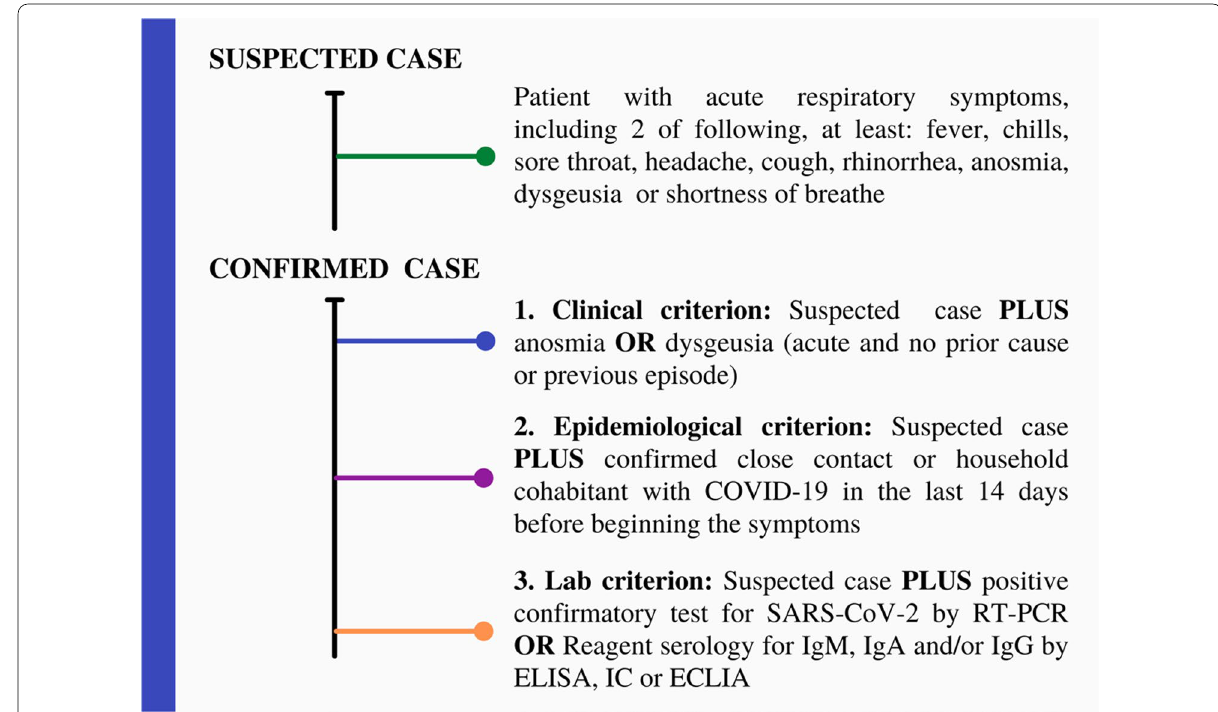
Fig. 1 Outcome definition: participants were classified according to the Brazilian Ministry of Health (BMH) criteria using the definition for COVID‑19. Individuals with more than 3 days of influenza‑like illness symptoms were considered for this